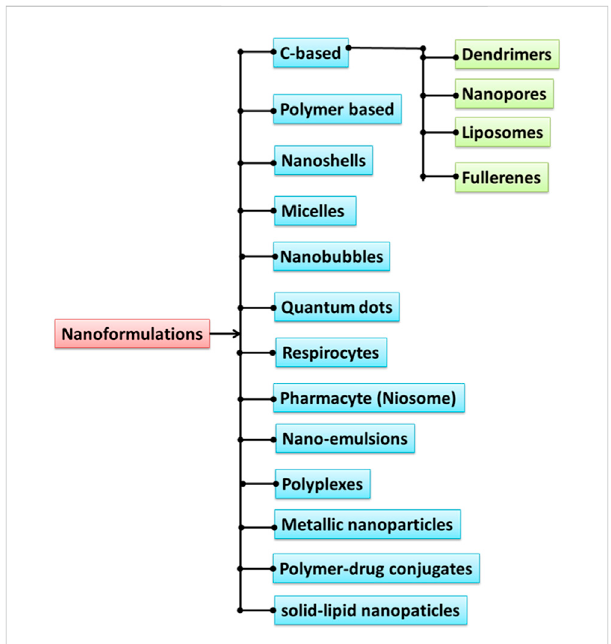
FIGURE 1 Different types of nanoformulations for therapeutic